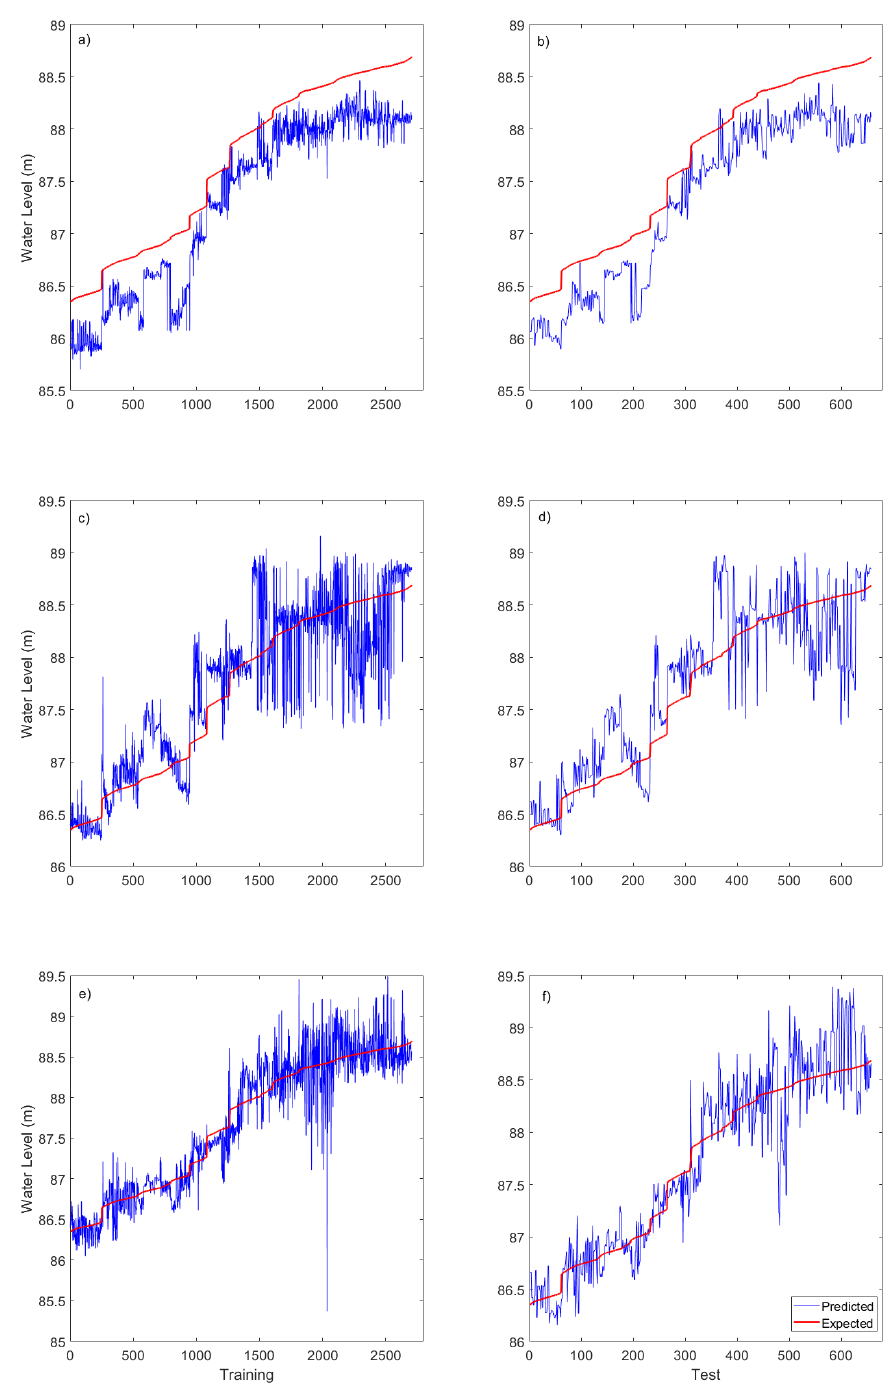
Figure 7. Estimation results using training and test dataset for ( a , b ) ResNet50, ( c , d ) MobileNetV2 and ( e , f ) proposed